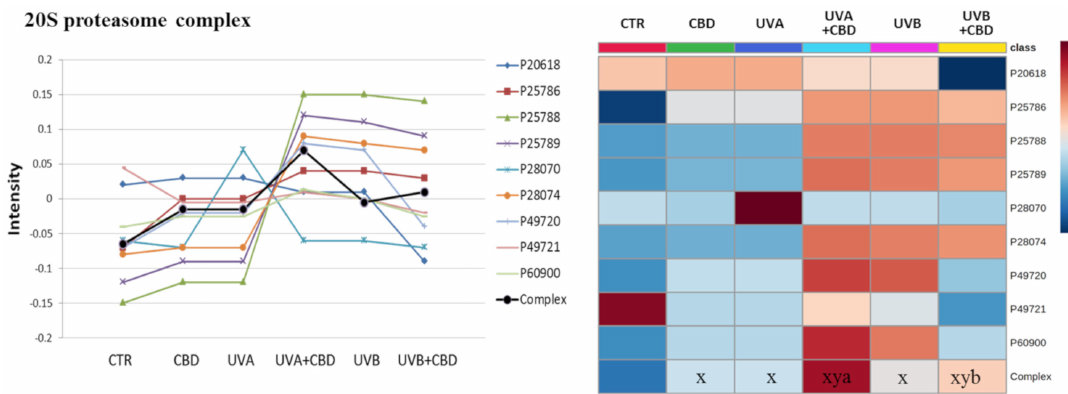
Figure 6. The point graph and heatmap showing the average intensity of proteins creating 20S proteasome complex in keratinocytes following UVA (30 J/cm 2 ) or UVB (60 mJ/cm 2 ) radiation and treated with cannabidiol (CBD, 4 µ M) in a three- dimensional culture model. Proteins IDs: P25786, P25788, P25789, P60900, proteasome subunit α type-1, -3, -4, -6; P20618, P49721, P49720, P28070, P28074, proteasome subunit β type-1, -2, -3, -4, -5. Statistical significances showed only for the whole complexes. x: statistically significant differences vs. non-treated cells, p < 0.05; y: statistically significant differences vs. CBD-treated cells, p < 0.05; a: statistically significant differences vs. UVA-irradiated cells, p < 0.05; b: statistically significant differences vs. UVB-irradiated cells, p <